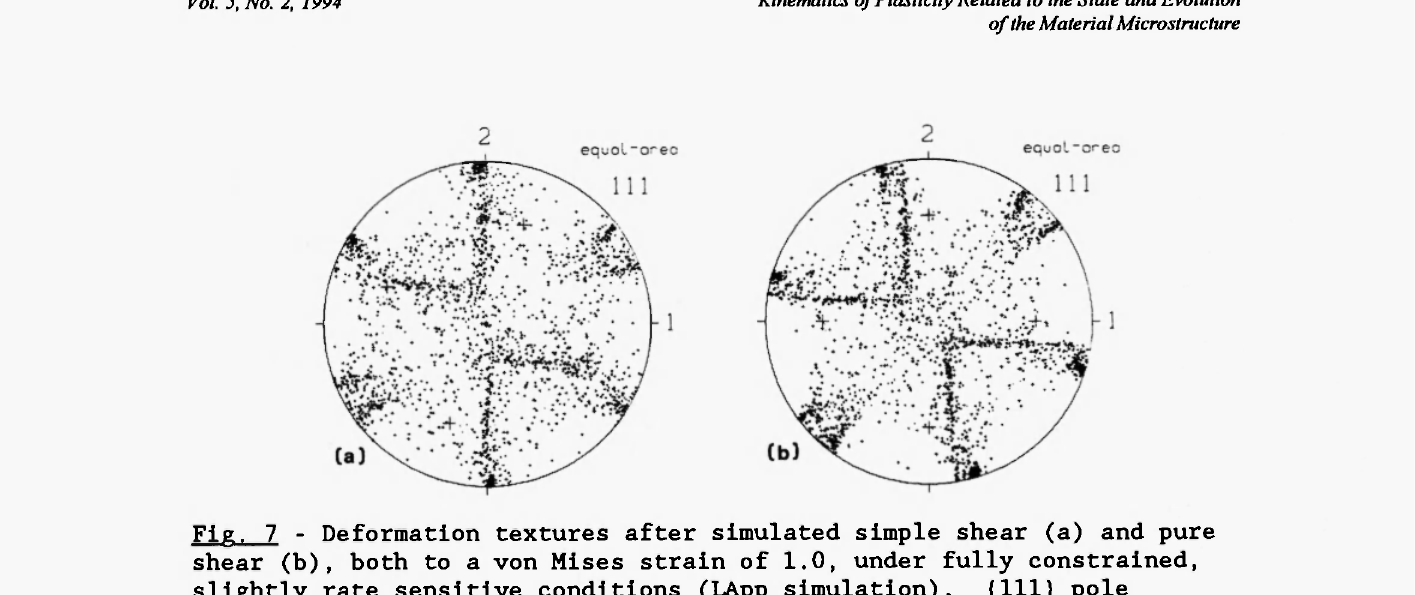
Fig. 7 - Deformation textures after simulated simple shear (a) and pure shear (b), both to a von Mises strain of 1.0, under fully constrained, slightly rate sensitive conditions (LApp simulation). {111} pole figures in equal-area